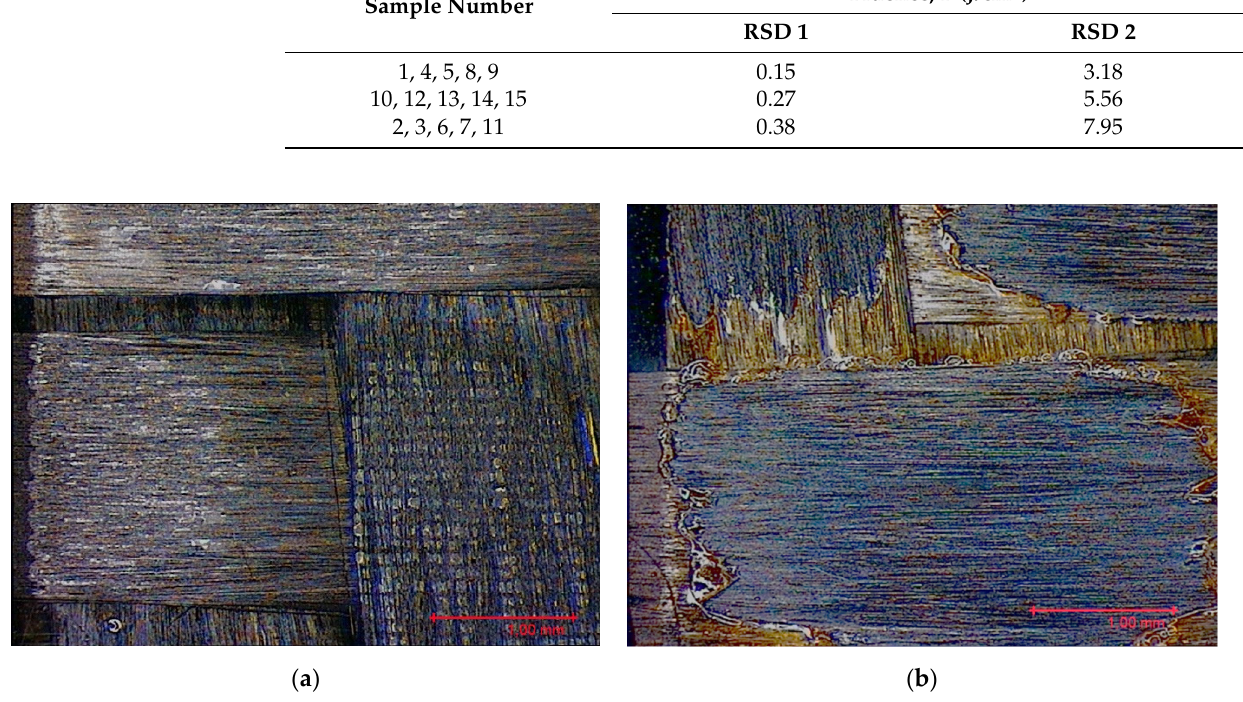
Figure 4. Surface obtained using ( a ) F = 0.15 J/cm 2 and ( b ) F = 7.95 J/cm 2 . Preliminary morphological analyses confirmed a stronger interaction between the laser beam and material as the fluence increased. Table 6 depicts the morphologies of samples belonging to the said six macro groups, sorted according to F values increasing from left to right and from top to bottom. For the sake of space, the images reported are limited to one sample per fluence value, taken as representative of the relative macro-group, within which all samples exhibited nearly the same morphology after laser